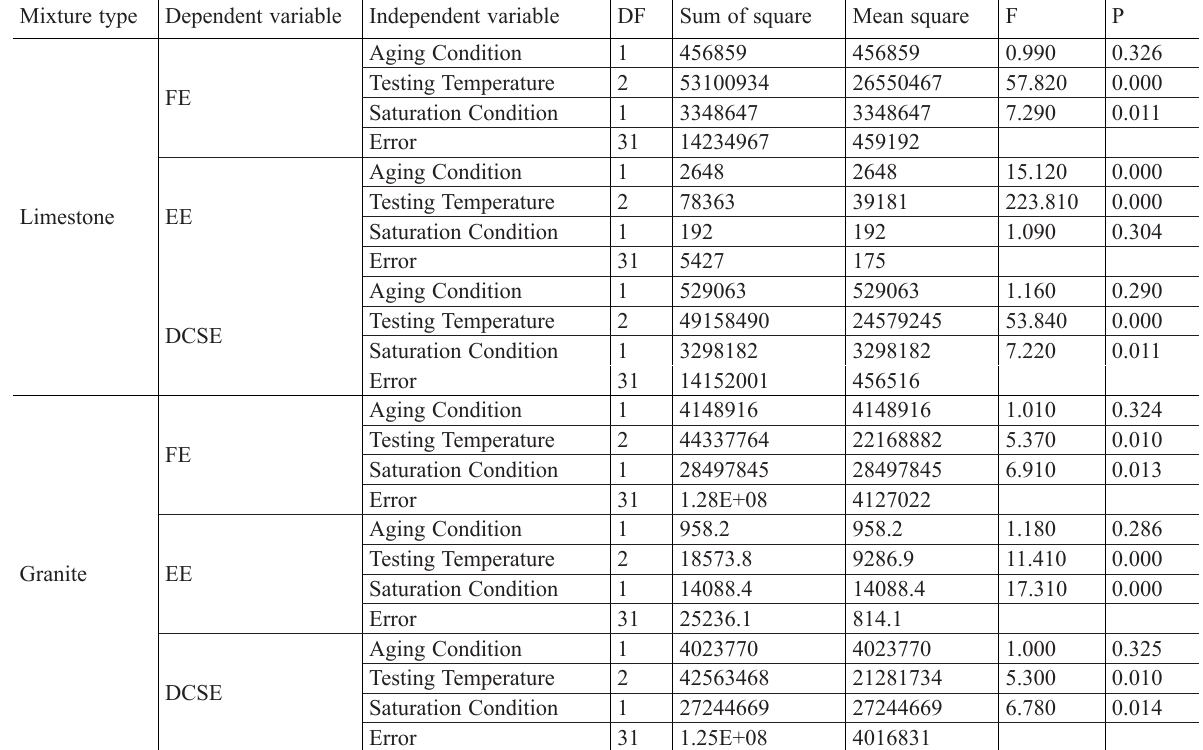
Table 4. Results of ANOVA test on sensitivity of different responses to independent factors Mixture